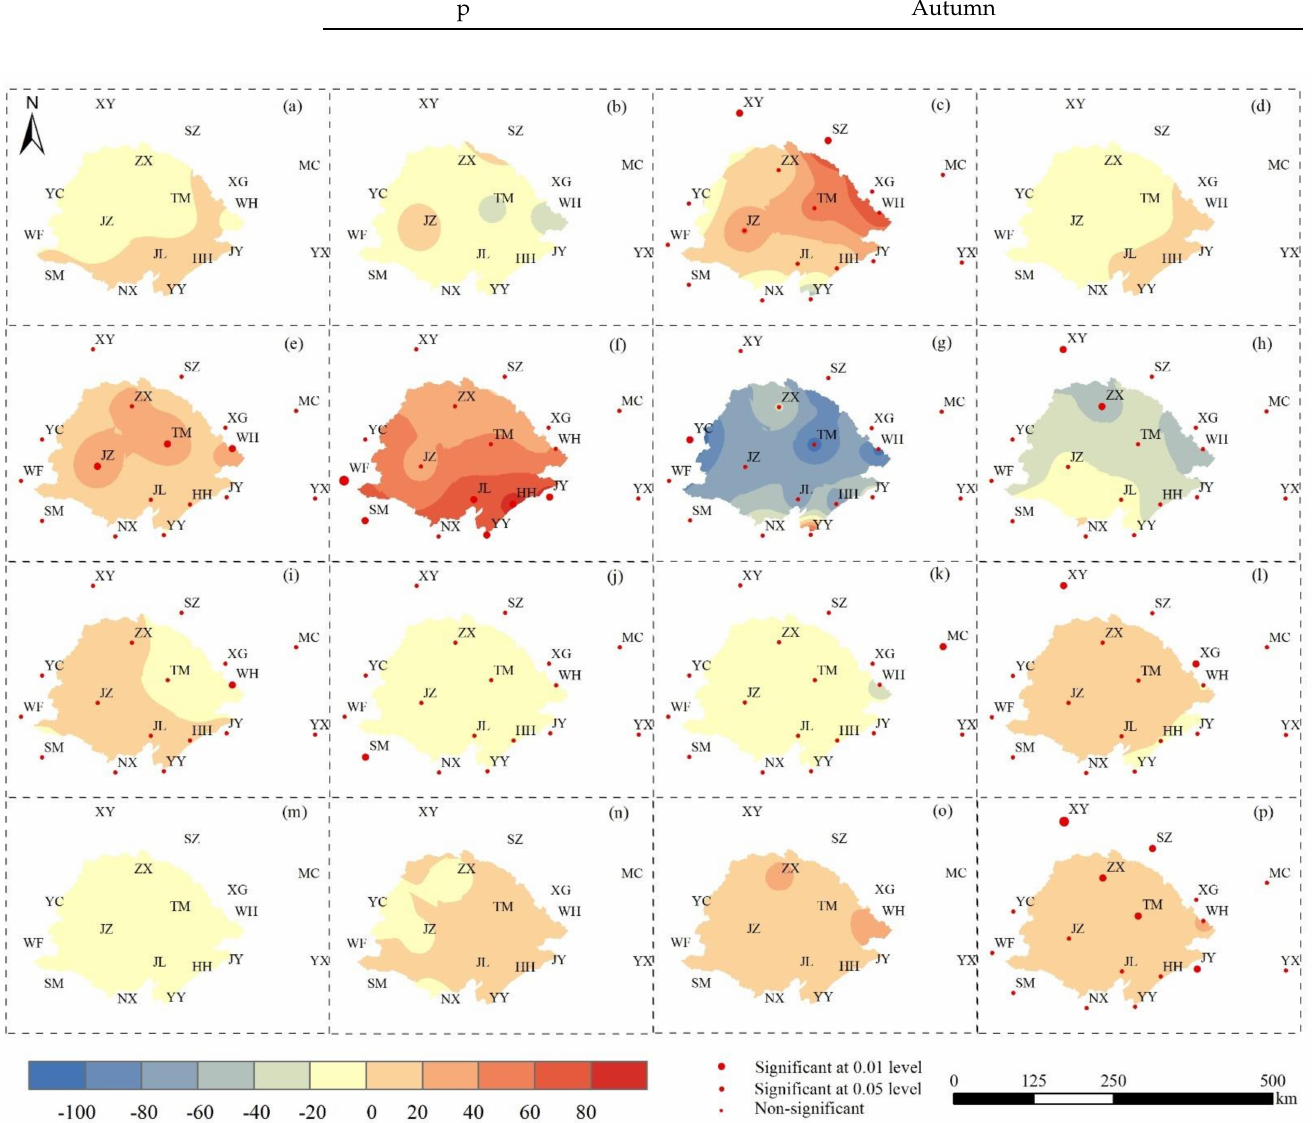
Figure 7. Precipitation and ET 0 anomalies in JHP during the El Niño years. A detailed description of the subgraphs is shown in Table